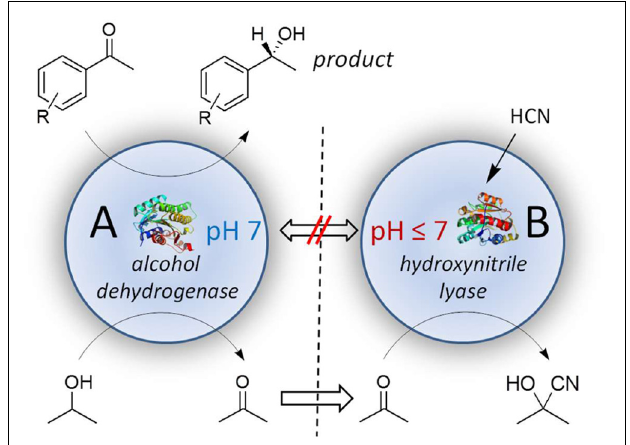
FIGURE 9 | Lk ADH- Me HNL cascade reaction with one or two compartmented reaction zones; 1 compartment: only Lk ADH-compartments (open squares), 2 compartments: Lk ADH-compartments at pH 7 and Me HNL-compartments at pH 5 (open circles); reaction conditions: 30 ◦ C, 5 mL MTBE, 10 mM acetophenone, 100 mM 2-propanol and 200 mM hydrogen cyanide for the 2 compartment-reaction, enantiomeric excess of ( R )-1-phenylethanol ≥